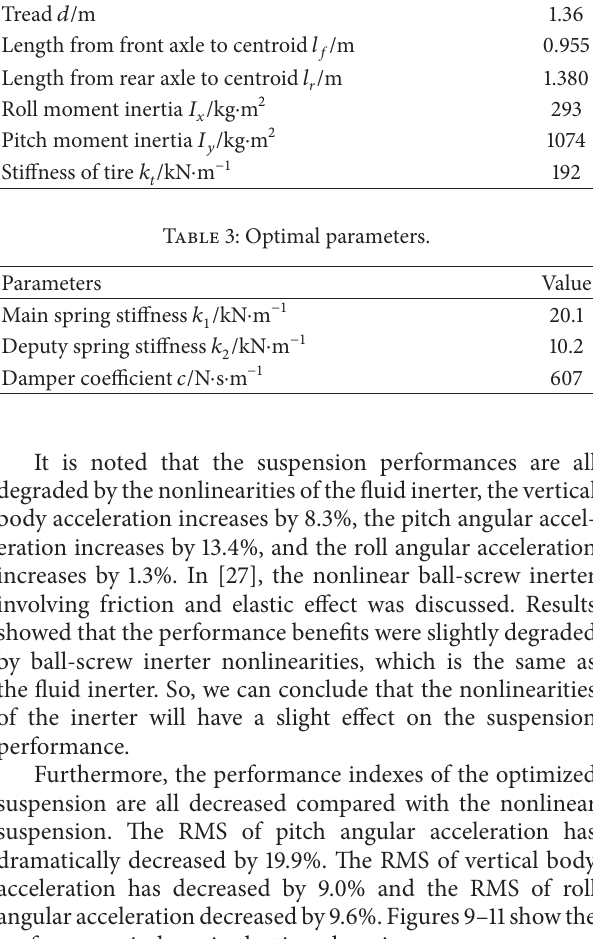
Figure 10: Pitch angular acceleration.